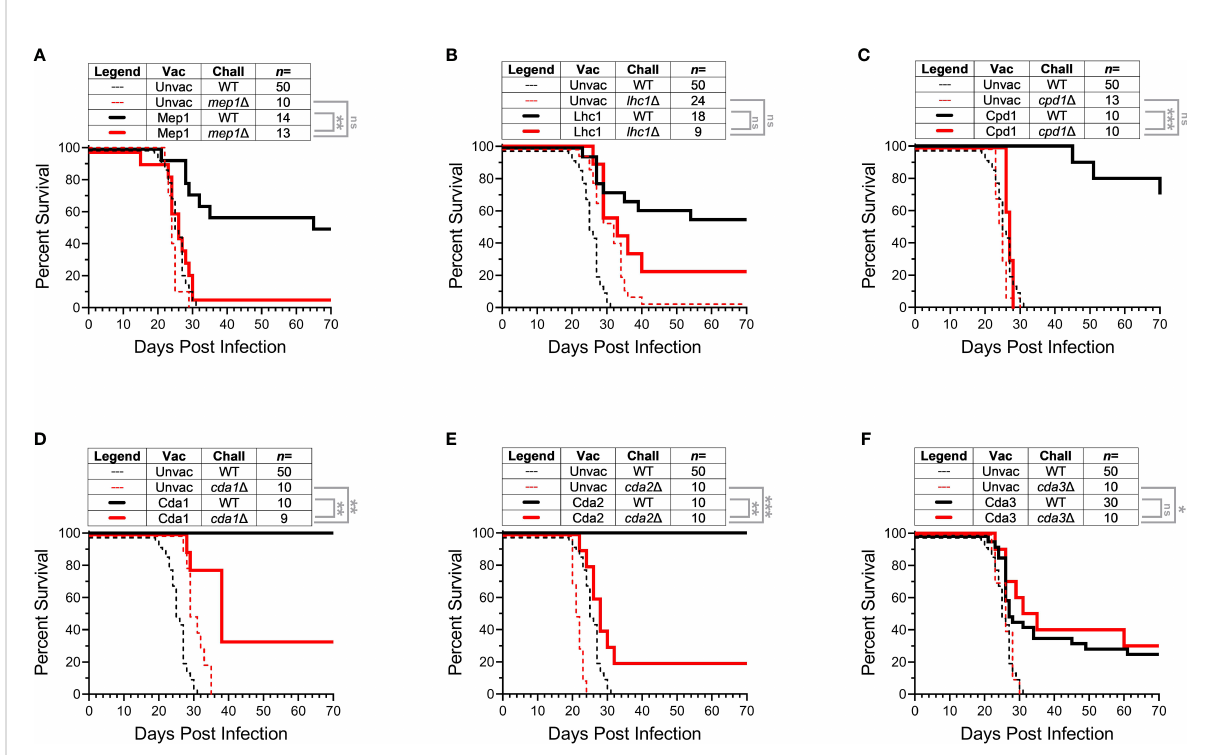
FIGURE 1 Infection with Cryptococcus strains deleted of protein used for vaccination. BALB/c mice received three subcutaneous GP-recombinant protein vaccines containing 10 m g antigen/dose before they were challenged with 2x10 4 CFU of the indicated strain of Cryptococcus neoformans . Survival was measured until 70 DPI. For each group, data were combined from a minimum of two independent experiments. Vaccine antigens either had no cryptococcal homologs (A, B), belonged to the Cpd protein family (C) , or the Cda protein family (D-F) . C. neoformans KN99 was used as the wild-type strain (WT) and compared to single gene deletion strains corresponding to each studies ’ vaccine protein. The number of mice per group is indicated by n =. Kaplan-Meier survival curves were compared using the Mantel-Cox, log-rank test. To adjust for multiple comparisons, signi fi cance was determined after applying the Bonferroni correction. ns, not signi fi cant; * signi fi cant at P ≤ 0.0125; ** signi fi cant at P ≤ 0.0025; *** signi fi cant at P ≤ 0.00025